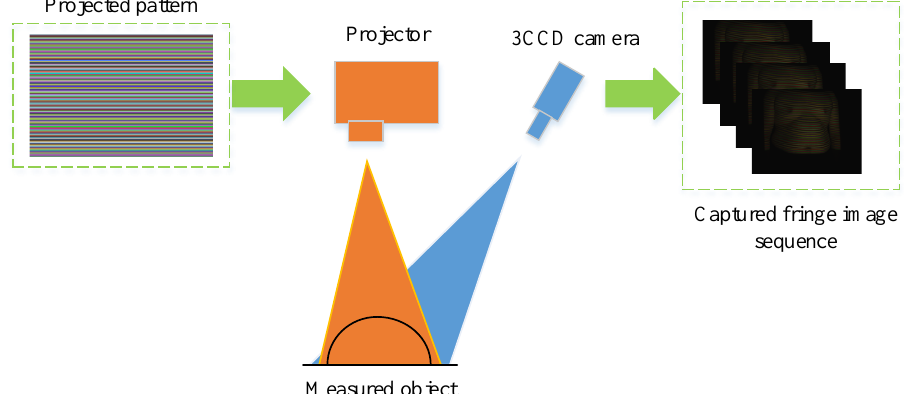
Figure 6. Schematic diagram of 3D reconstruction system. We selected 60 frames of fringe images for our experiment. Figure 7 shows the meas- ured area truncated from the image sequence of the human thoracic and abdominal sur- face. Figure 7a shows the surface after the projection of the composite color fringe pattern. We truncated the image region of the human thoracic and abdominal surface for color- coupling correction and separation [23]. The separated fringe image sequences are shown in Figure 7b – d.